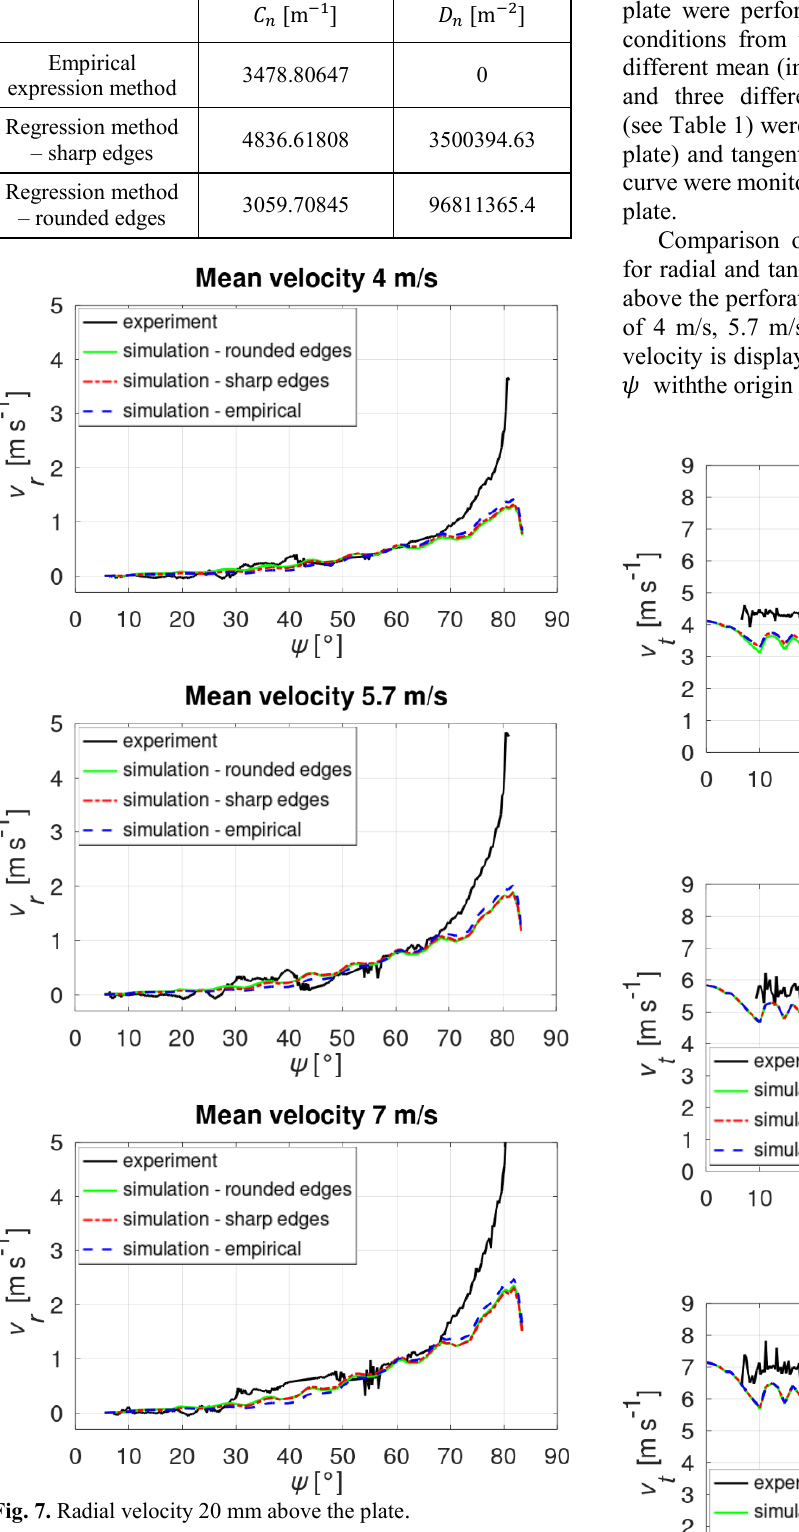
Fig. Radial velocity 20 mm above the plate . 7.